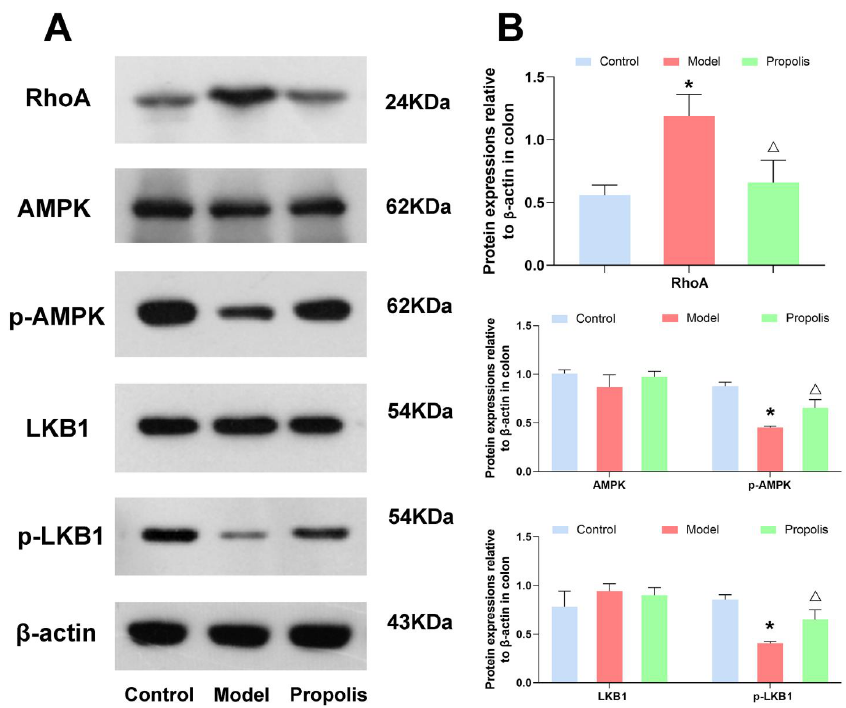
Figure 6. Effects of propolis on the expressions of LKB1/AMPK signaling pathway in the colon tissue. ( A ) Western blotting analysis of the expression level of RhoA, AMPK, p-AMPK, LKB1 and p-LKB1 in colon tissues. ( B ) Quantitative analysis of the western blotting data. * Denotes p < 0.05 vs. control group; (cid:52) p < 0.05 vs. model